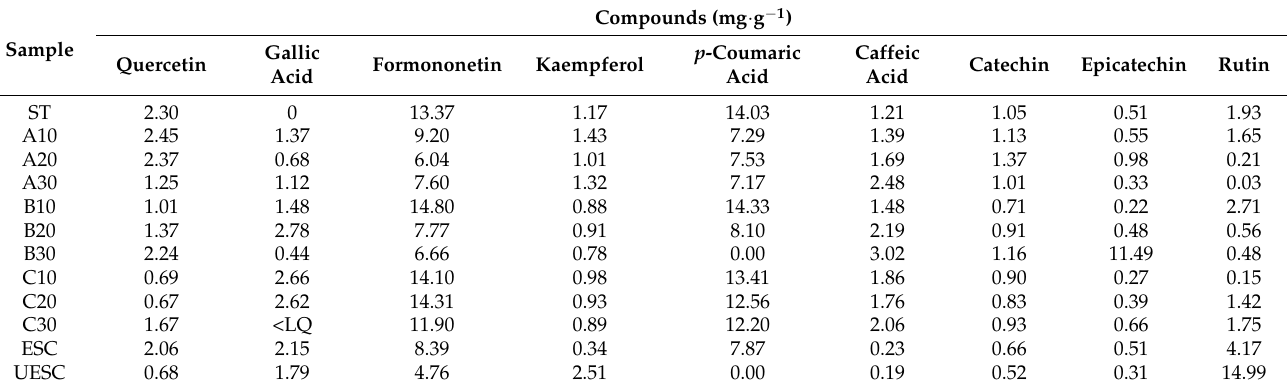
Table 1. Quantification of the nine major phenolic compounds by HPLC in different green propolis extracts obtained by ultrasound-assisted LPE and